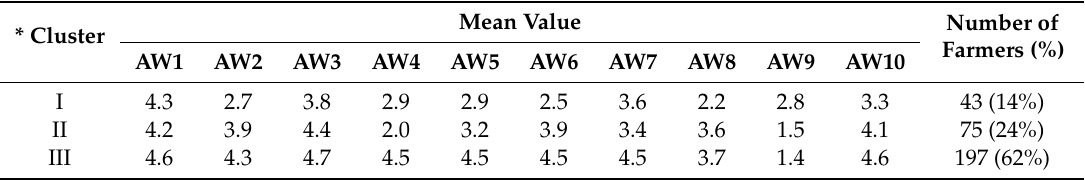
Table 6. Cluster analysis based on farmers’ awareness of the low yield of conventional rice production. * Cluster